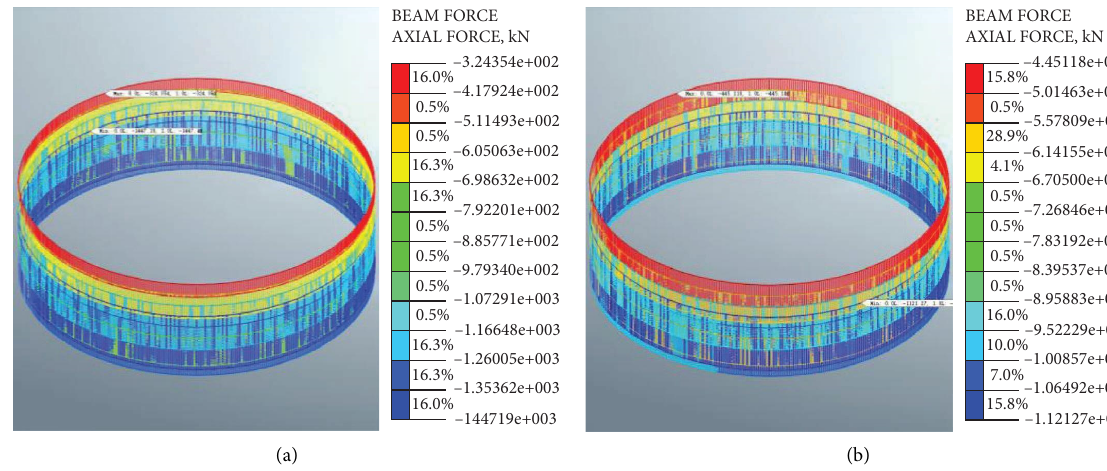
Figure 34: Working condition 7 lining axial force (a) without pore water pressure and (b) with pore water pressure applied.